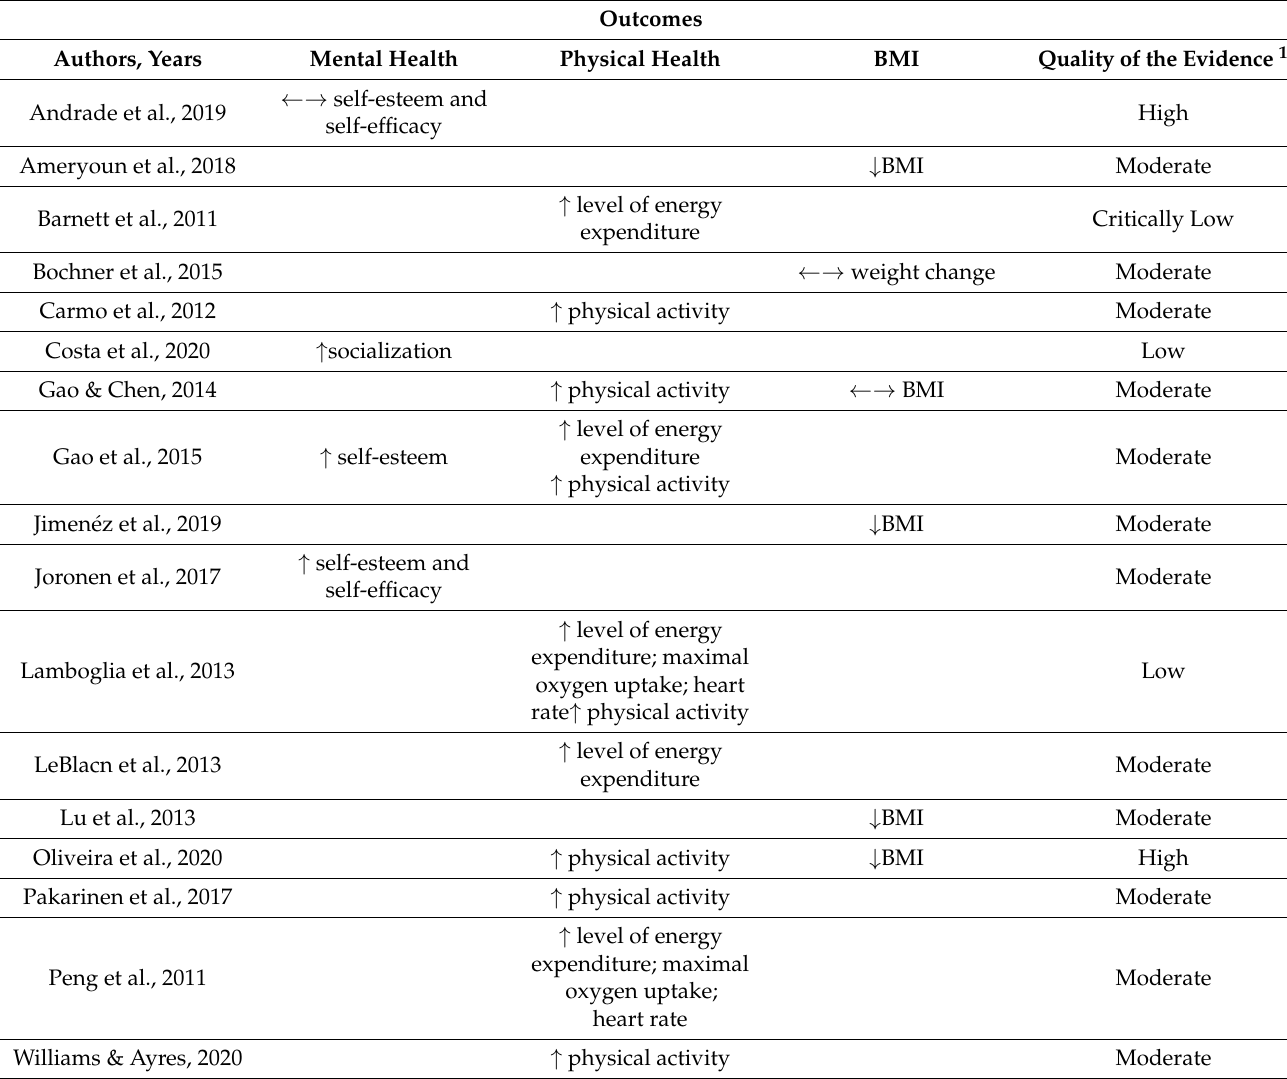
Table 2. Summary of results and methodological quality of included studies (n =